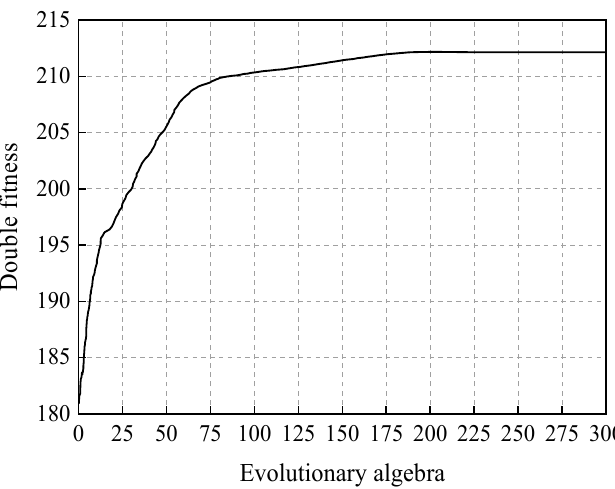
Figure 16. Diagram of the relationship between evolutionary algebra and optimal individual val- ues.